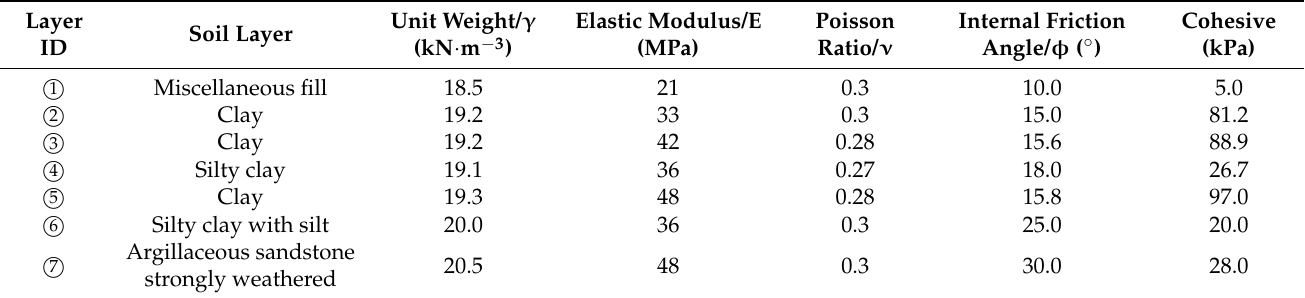
Table 1. Parameters of soil layer.